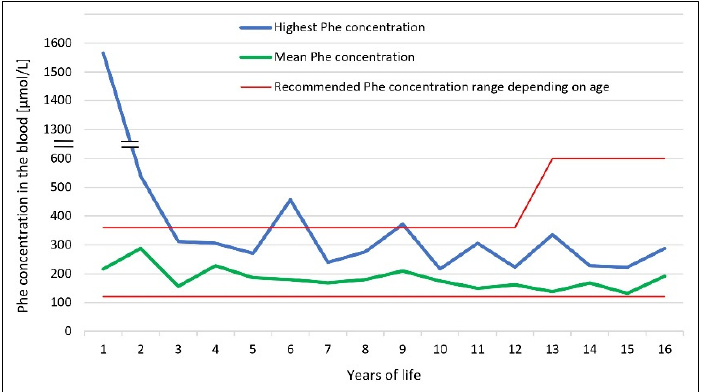
Figure 2. The highest and mean annual blood phenylalanine (Phe) concentrations in a boy suffering from phenylketonuria and Alazami syndrome.